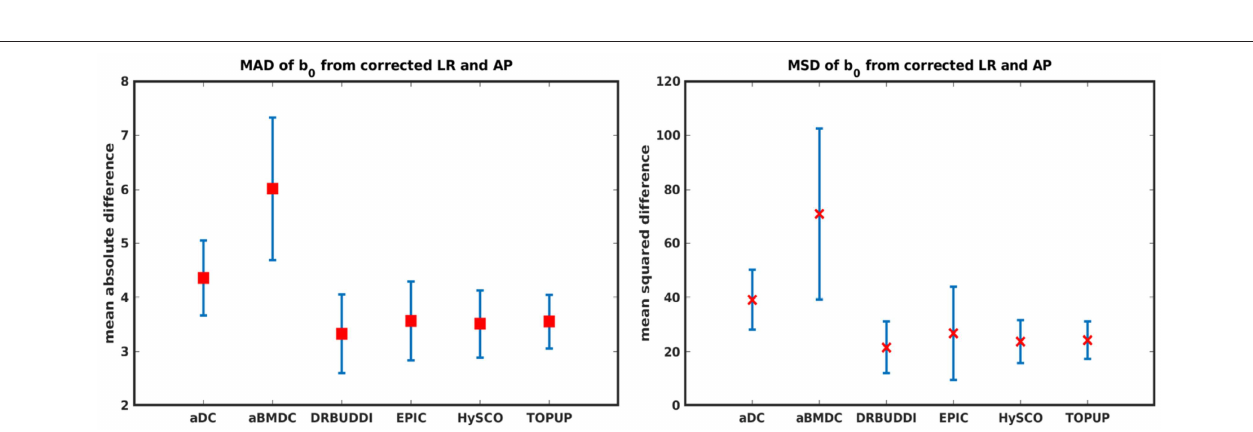
FIGURE 16 | MAD and MSD of b 0 from corrected LR and AP for 40 dHCP subjects using the six methods. The error bars represent the standard deviation over subjects. In all cases DR-BUDDI produces the smallest difference.